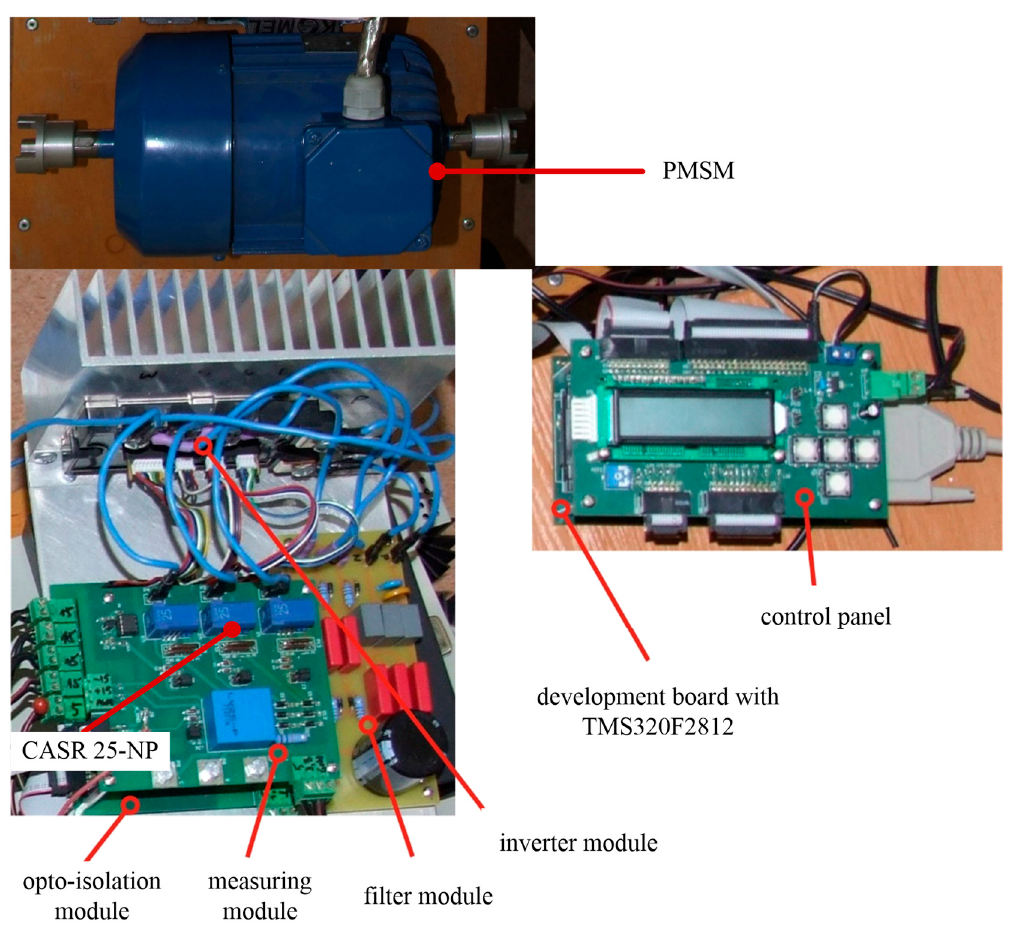
Figure 6. The picture view of the experimental setup with TMS320F2812.